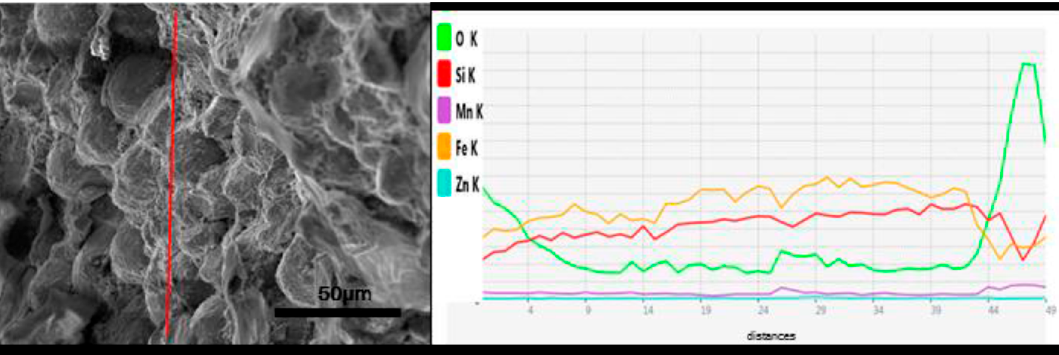
Figure 10. SEM micrographs of the Fe-Si/MnZn(Fe 2 O 4 ) 2 composites sintered at 800 °C with EDS analysis (no corrosion).